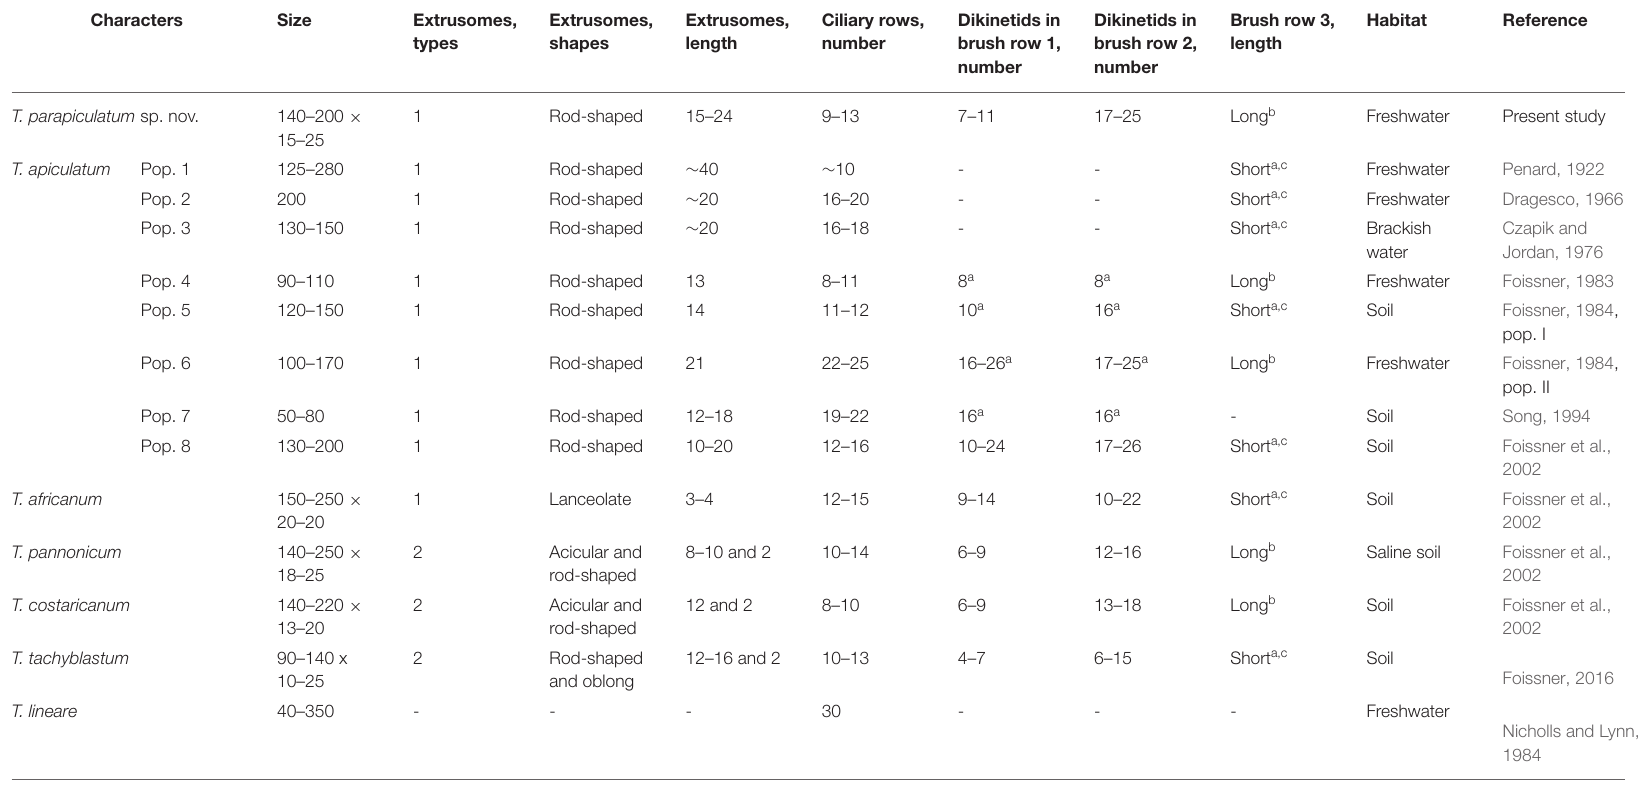
TABLE 4 | Comparison between Trachelophyllum parapiculatum sp. nov. and other congeners. Characters Extrusomes,